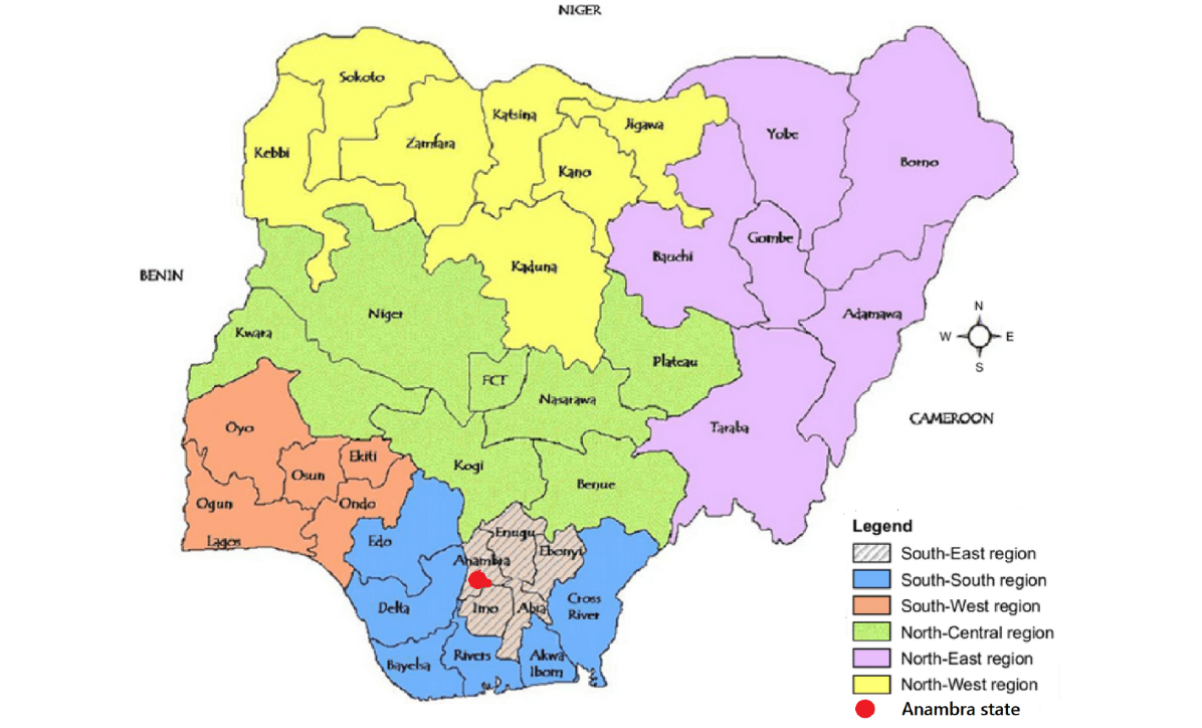
Figure 4. Map of Nigeria showing the six geopolitical zones and the 36 states